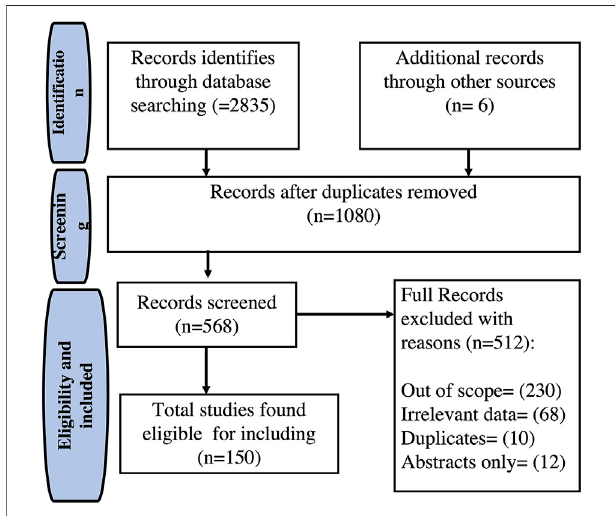
FIGURE1| Flowchartofthe selectionprocessofthe included studies of Eichhornia crassipes.